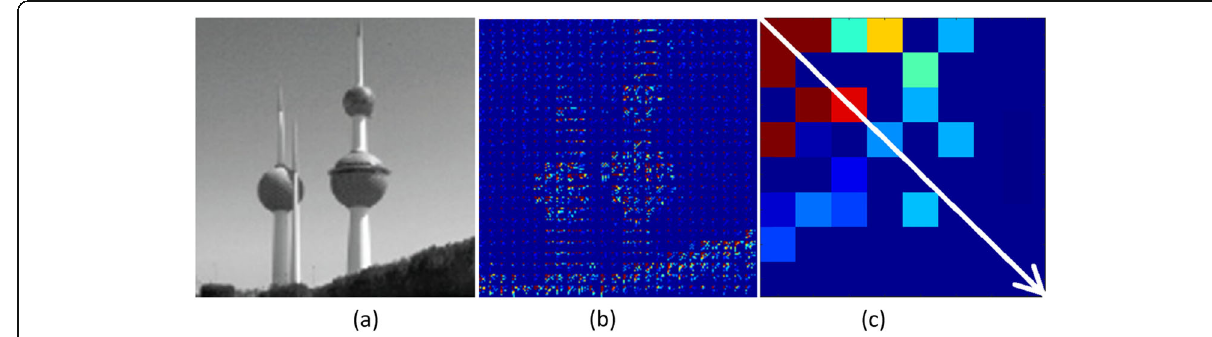
Fig. 2 a Cover image, ( b ) its DCT representation, and ( c ) a single DCT